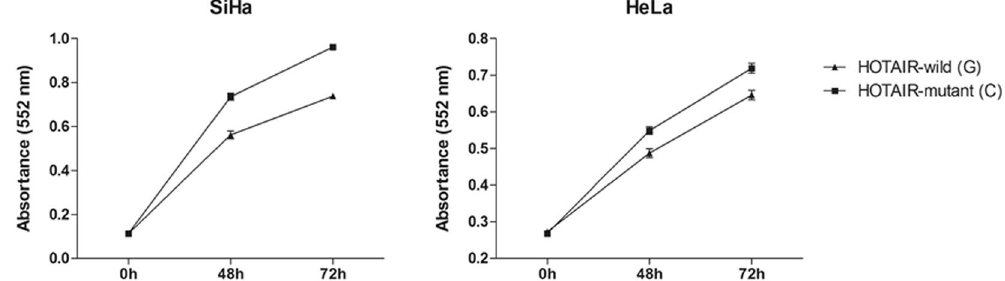
Figure 2. Effects of HOTAIR rs7958904 alleles on CC cell proliferation. Increased cell proliferation was observed in the CC cells transfected with plasmids containing mutant C allele over the wild G